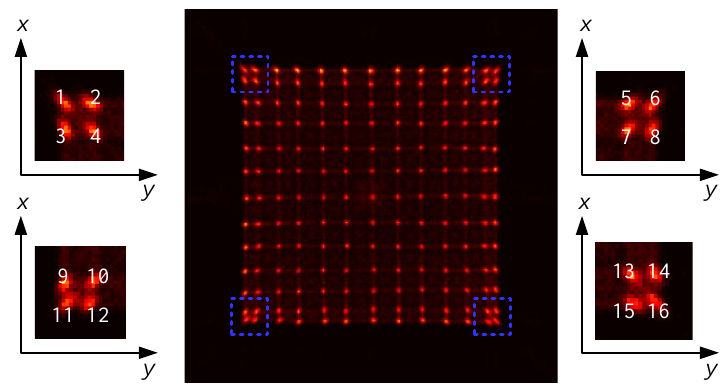
Figure 14. Figure illustrating how the flood histogram quality parameter was calculated.